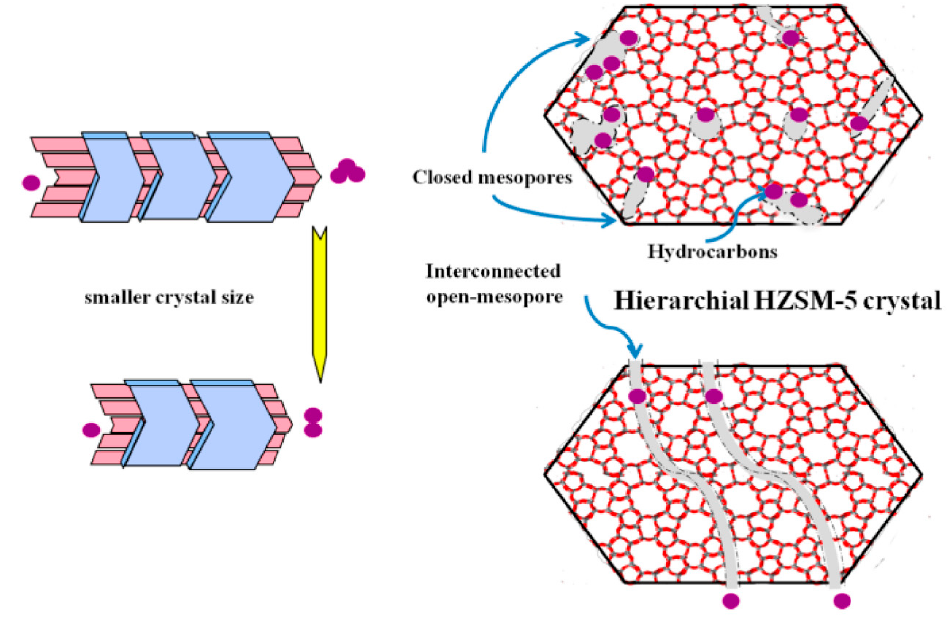
Figure 4. Schematic illustration of the main mechanism of enhanced diffusion [93]. Copyright (2018), with permission from MDPI.